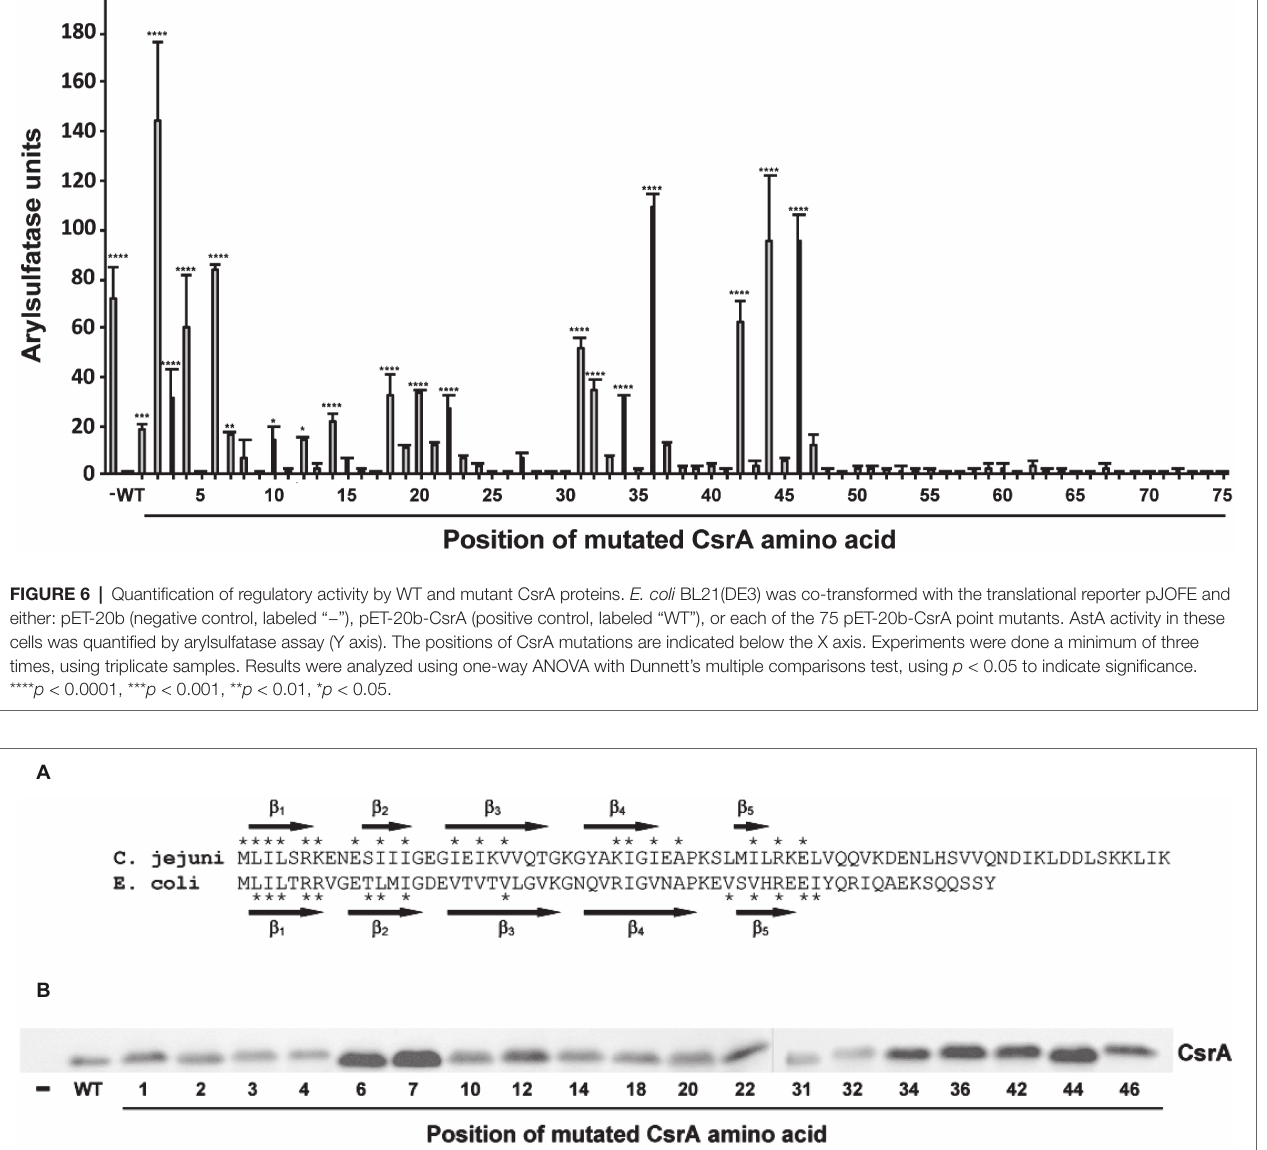
FIGURE 7 | RNA-binding amino acids and expression of CsrA. (A) Sequence alignment of C. jejuni and E. coli CsrA proteins. Proteins were aligned using Clustal Omega (Li et al., 2015), and the location of β strands β 1 - β 5 were predicted using BETApro (Cheng and Baldi, 2005). Asterisks indicate amino acids involved in RNA binding by the adjacent protein. E. coli data were taken from Mercante et al. (2006). (B) Expression of C. jejuni CsrA proteins in E. coli containing pJOFE. E. coli cells transformed with the translational reporter pJOFE and pET-20b (“−”), pET-20b-CsrA (“WT”), or the 19 CsrA point mutants that showed significantly higher AstA activity were tested in western blots using CsrA-specific polyclonal antiserum (Fields et al., 2016). All CsrA mutant proteins were expressed at levels equivalent to or higher than